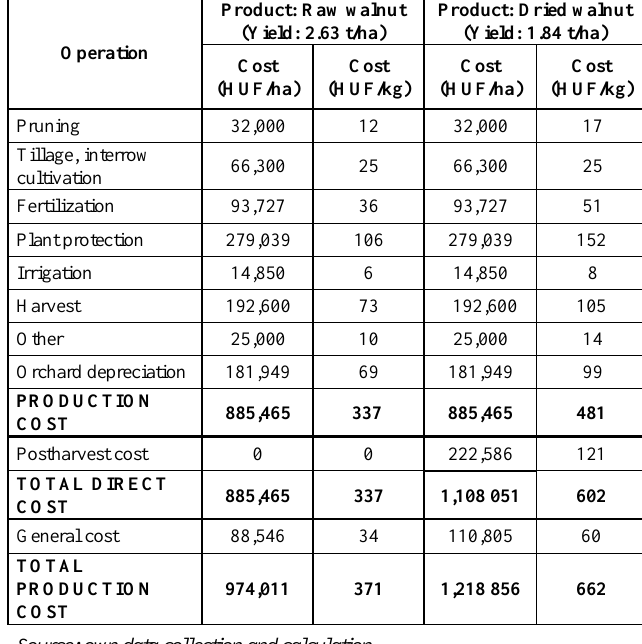
Table 2. Production cost of walnut plantation by different types of production operations in a full productive year